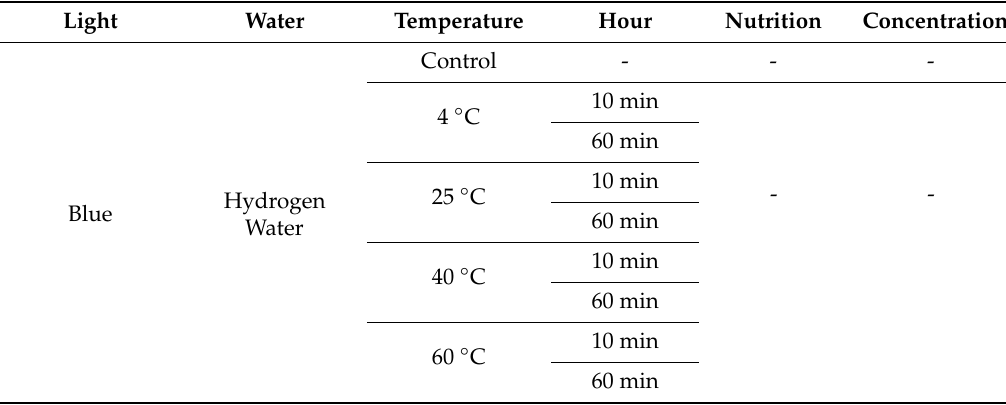
Table 1. Conditions of the barley sprout (BS) germination